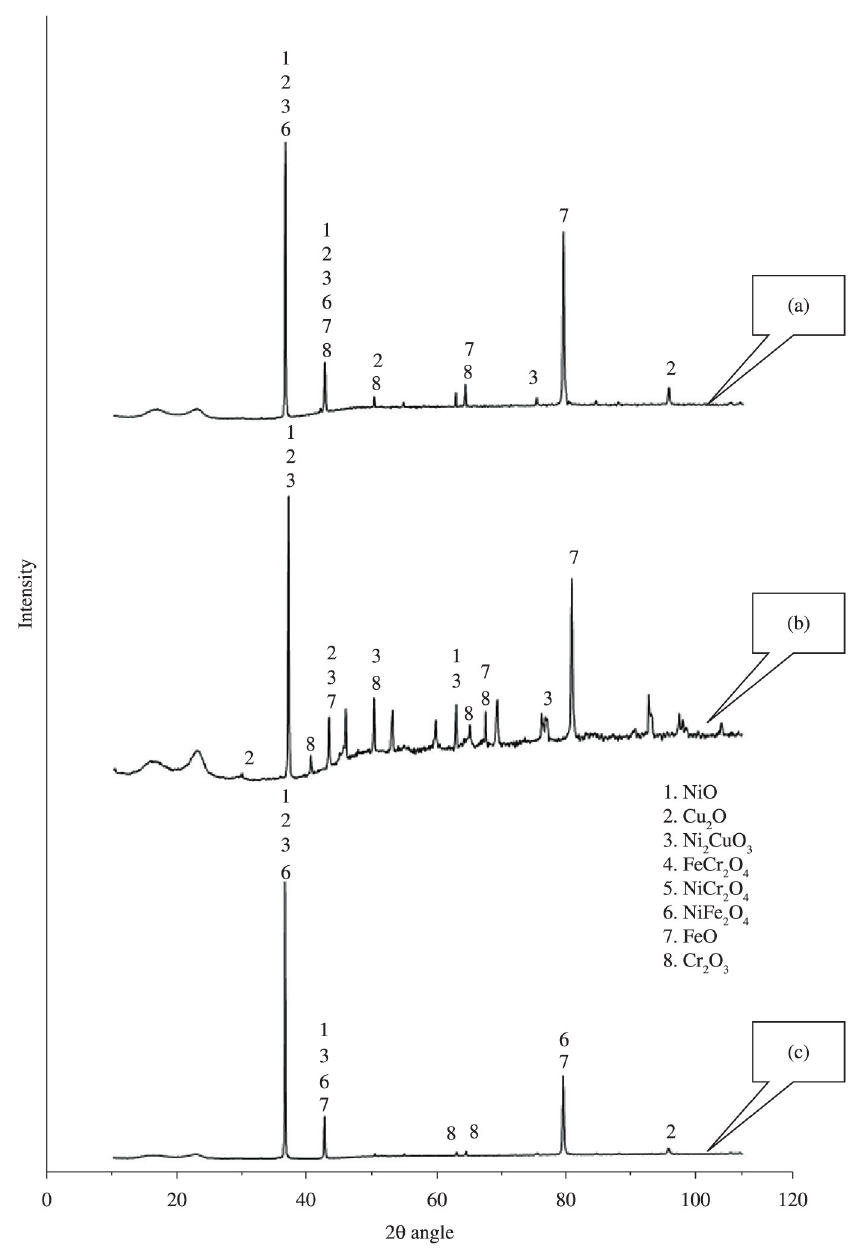
Figure 9. XRD analysis of hot corroded PCGTA welded dissimilar Monel 400 and AOSO 304 (Composite Region) employing (a) ER309L (b) ERNiCu-7 and (c) ERNiCrFe-3 subjected to the molten salt environment of Na